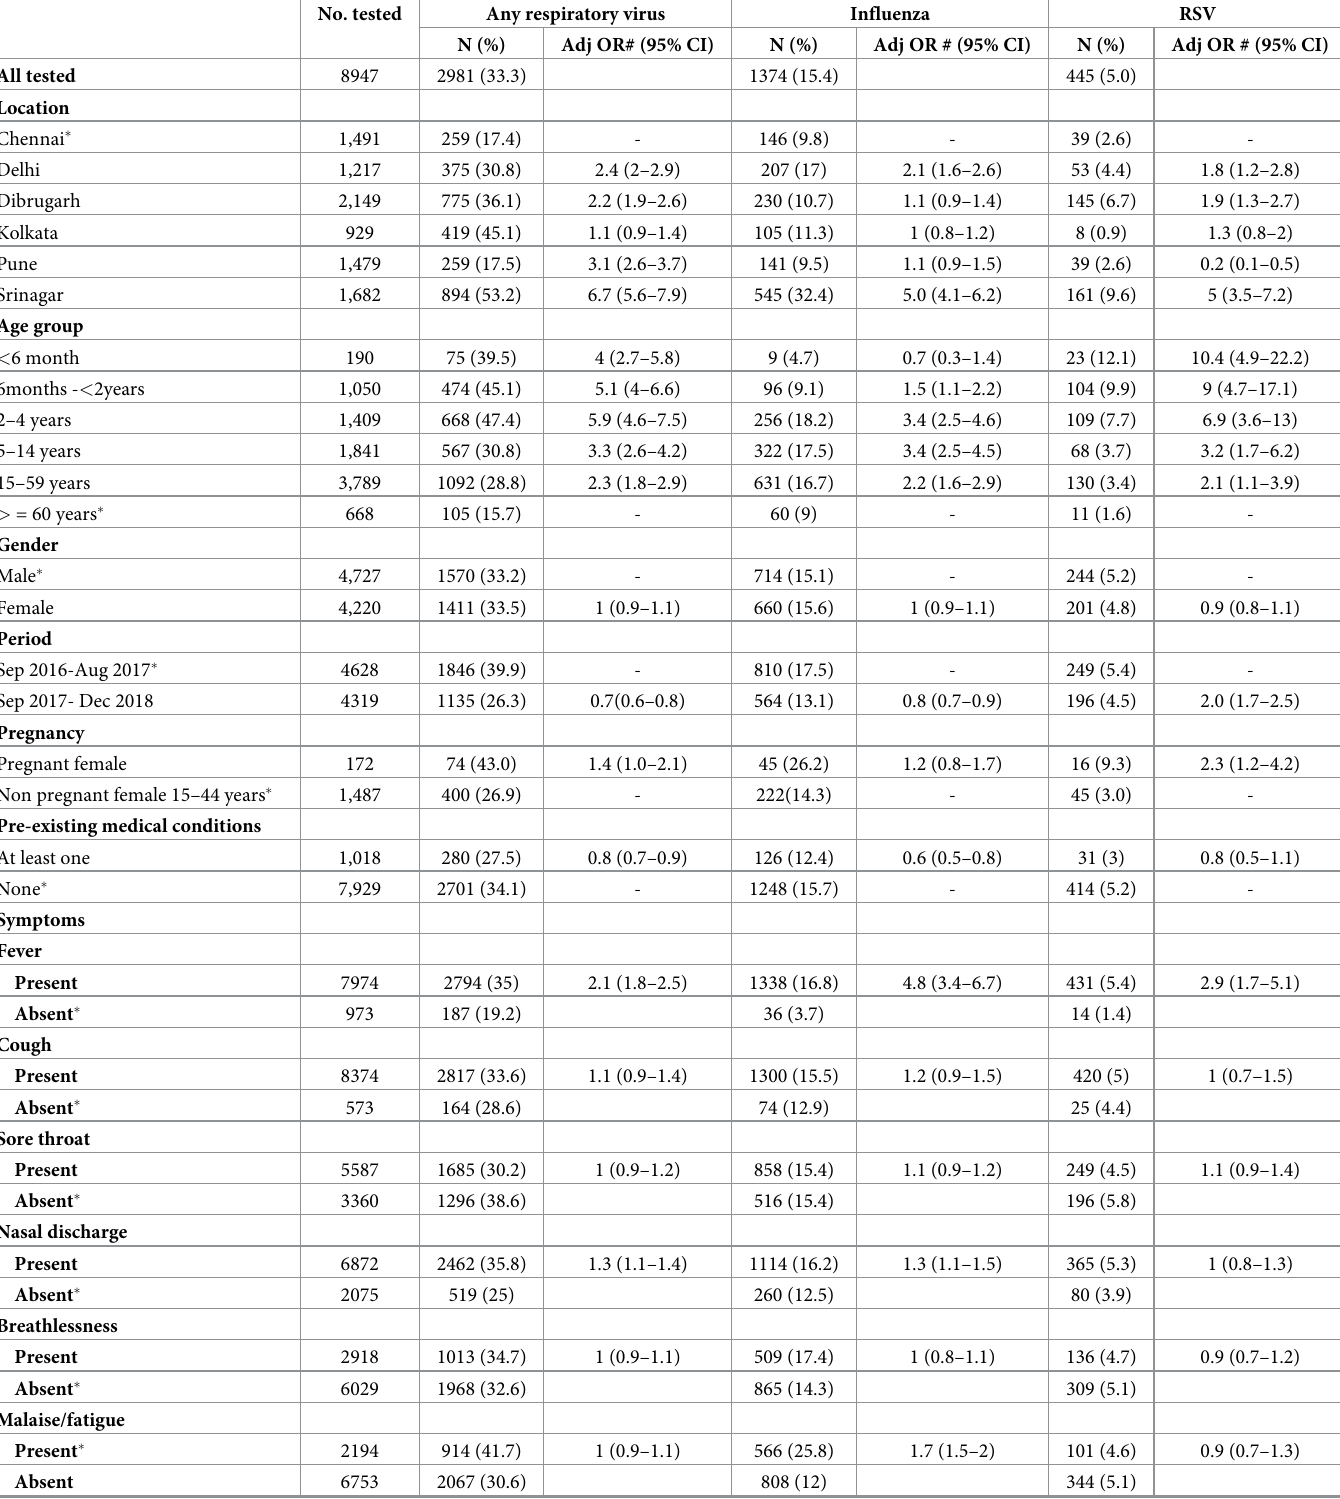
Table 1. Percent positive of respiratory viruses by clinical-epidemiological characteristic among outpatients with acute respiratory infection, India